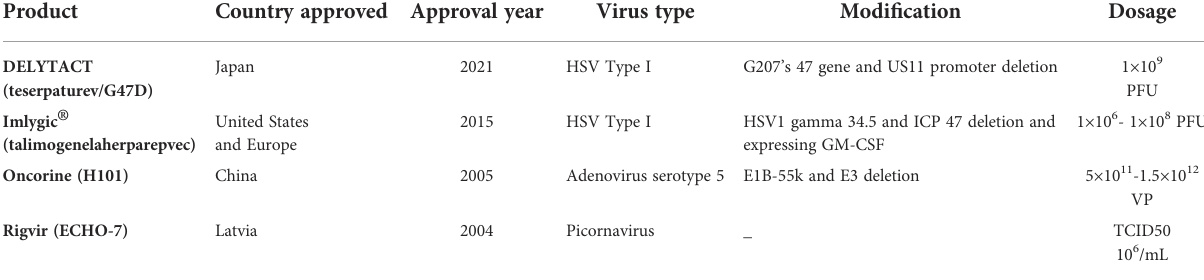
TABLE 1 Global-approved oncolytic viruses (OVs).